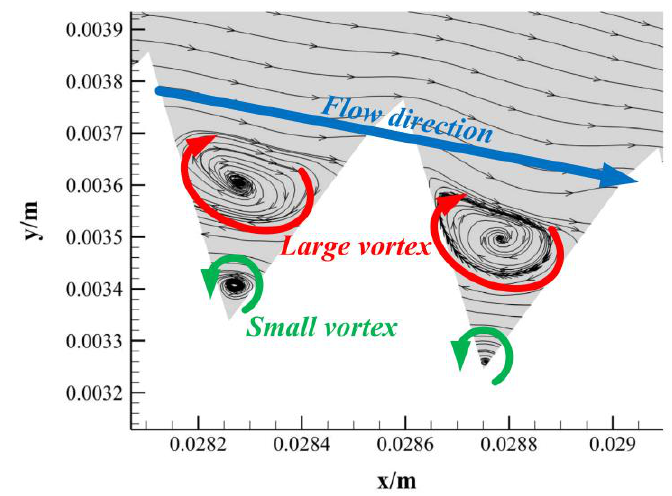
Figure 25. Streamlines in the groove. The blue straight arrow represents the direction of the flow around the hydrofoil; the red curved arrow represents the direction of the large vortex near the external flow field; and the green curved arrow represents the direction of the small vortex in the bottom of the microgrooves.